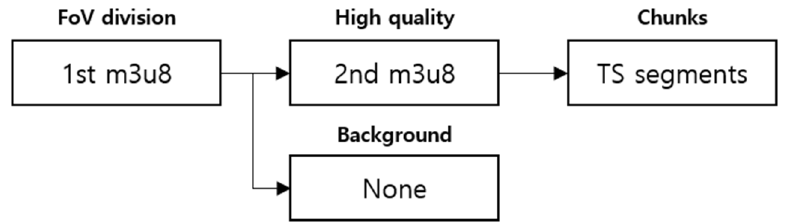
Figure 15. Hierarchy of m3u8.